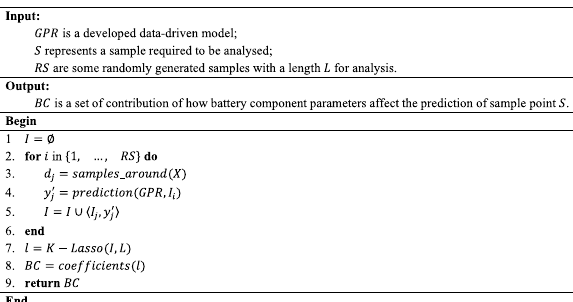
Algorithm 1. Detailed procedure to equip LIME for local effect analysis of component parameters.